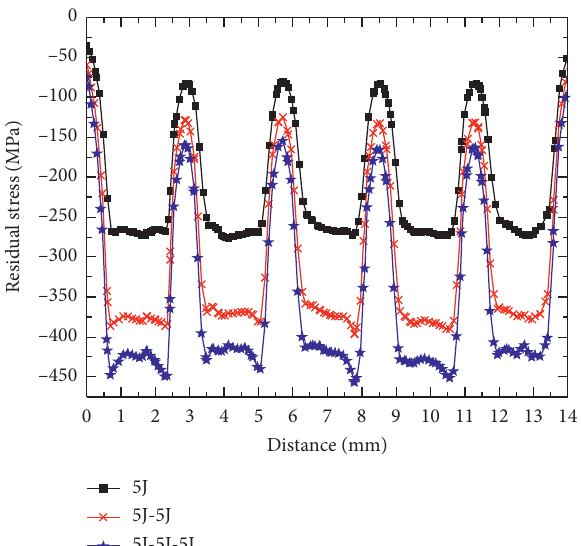
Figure 11: Curves of residual stress distribution of sample surface with different number of